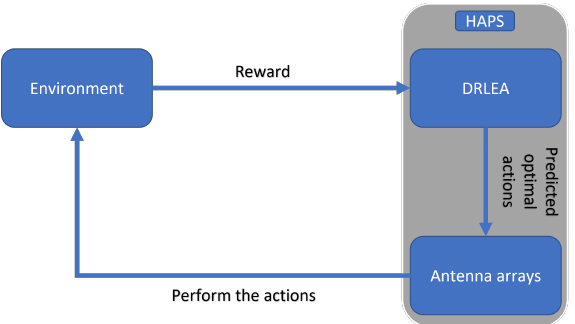
Figure 7. The pipeline of the proposed DRLEA